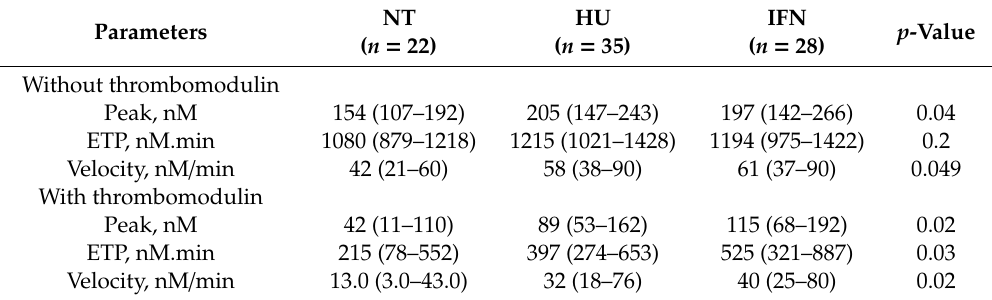
Table 5. Parameters of thrombin generation according to cytoreductive treatment group.